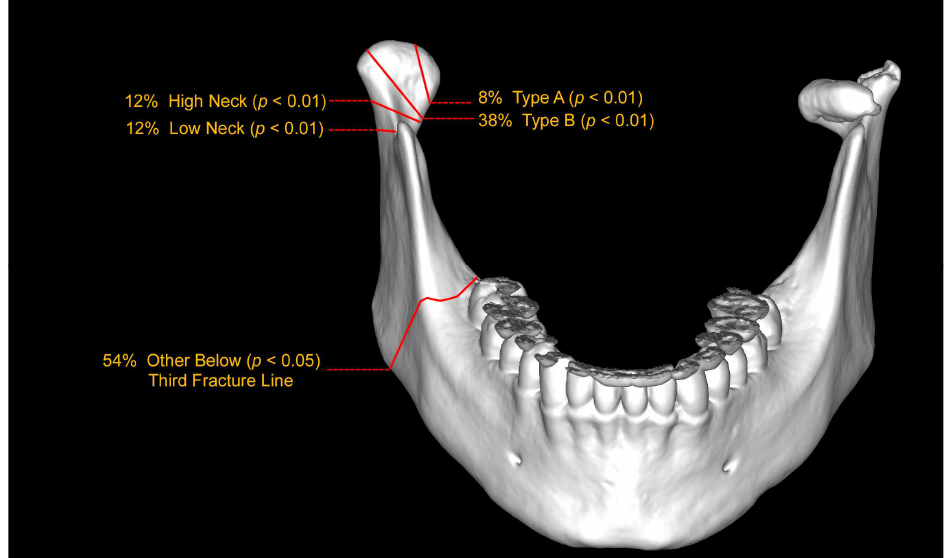
Figure 7. Evaluation of the location of a concomitant fracture in patients with bilateral mandibular condylar process fractures when one of the fractures is a mandibular head fracture. Most often, the second mandibular condylar process fracture is a type B head fracture, followed by neck fractures and a type A head fracture. At the same time, more than half of the patients have a third and further fracture fissure outside the condylar processes (most often a fracture in the mandibular body).